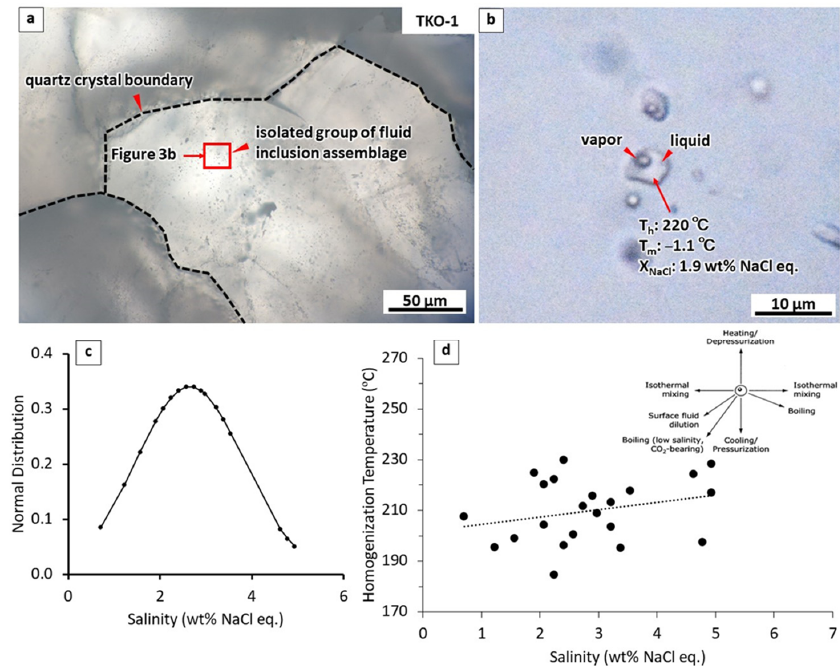
Figure 3. ( a ) Photomicrographs showing the fluid inclusion assemblages inside quartz crystals from the Thongkai-Ok Au deposit; ( b ) two-phase liquid-vapor inclusions; ( c ) graph showing normal distribution of fluid inclusion salinity; ( d ) correlation diagram of homogenization temperature (T h ) vs. salinity, the typical trend in Th-salinity from Wilkinson (2001)